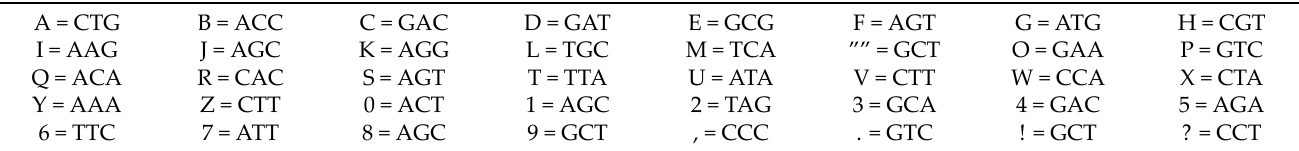
Table 1. An example DNA Encryption Look‑up